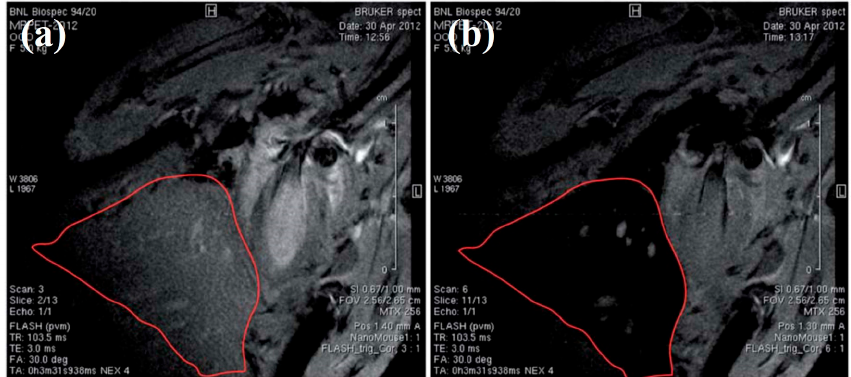
Figure 7. Representative T 2 *-weighted MR images of mouse liver acquired ( a ) before and ( b ) after the administration of non-radiolabeled IONs (Used with permission of Royal Society of Chemistry, from [64]; permission conveyed through Copyright Clearance Center, Inc.).